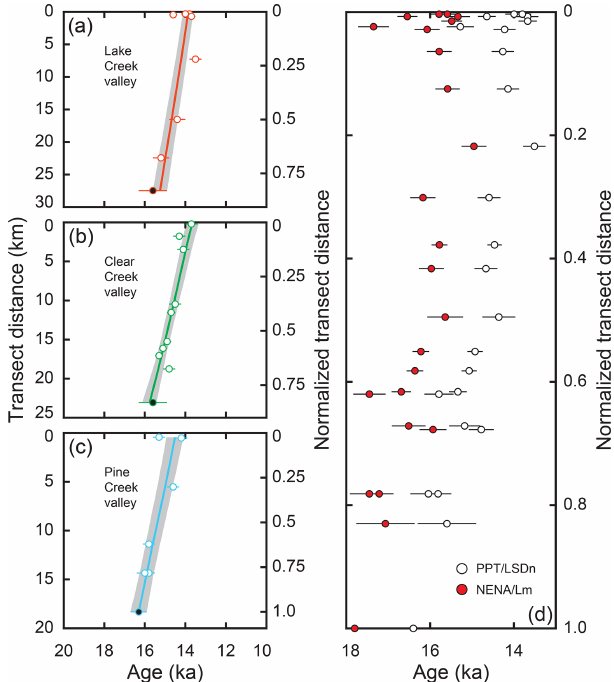
Figure 4. Summary plots of 10 Be ages and BACON statistical anal- ysis results. (a) Lake Creek valley (orange), (b) Clear Creek valley (green), and (c) Pine Creek valley (blue). Ages in solid black fill at the bottom of each transect are from recessional moraine ages (Young et al., 2011; Schweinsberg et al., 2020). BACON results are mean (color lines) and 95% confidence intervals (gray shad- ing). The left y axes are total valley-floor distances from the LGM moraine to the base of each respective cirque headwall (note that scales are different because valley lengths are different). The right y axes are the same but normalized values; 1 indicates the LGM moraine position and 0 the base of the cirque headwall. (d) Distribu- tion of all ages using the PPT (Lifton et al., 2015) and LSD n (Lifton et al., 2014) as well as the NENA (Balco et al., 2009) and Lm (Lal, 1991; Stone, 2000) production rate calibration and scaling scheme combinations. All other reasonable combinations mentioned in the text produce ages that fall somewhere between the ages calculated using the PPT–LSD n and NENA–Lm